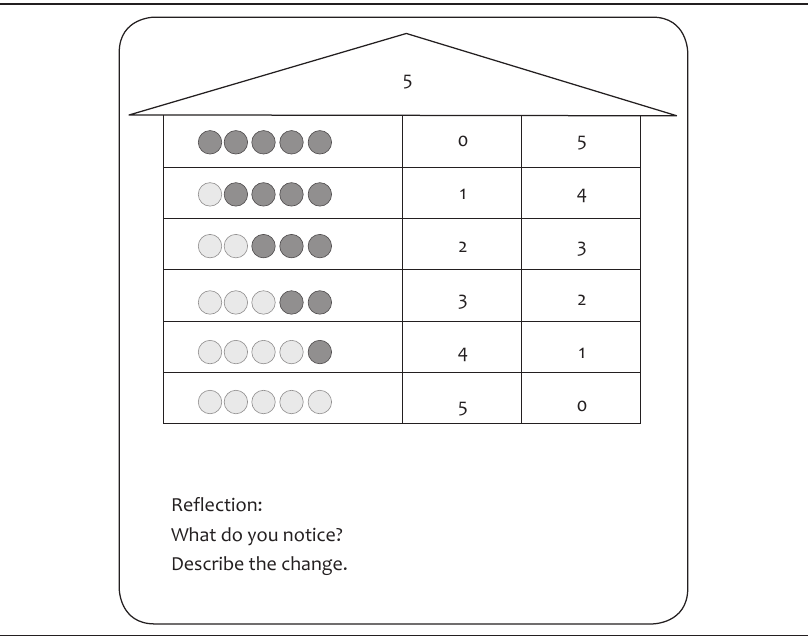
Figure 7: Finding an order – the ‘number house’